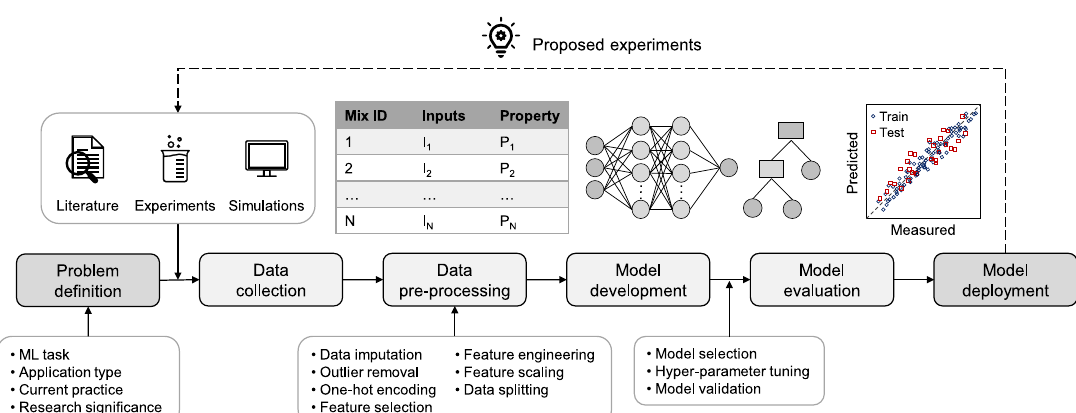
Fig. 4 General work fl ow of machine learning (ML) in concrete science. Six steps are typically involved in ML work fl ows, from (1) problem de fi nition, (2) data collection, and (3) data pre-processing to (4) model development, (5) model evaluation, and (6) model deployment. Developed ML models can be deployed to identify new concrete mixtures with desired properties, which are then validated through empirical or computational experiments, with the outcome appended to the collected datasets and iteratively calibrating the models. Relevant terminology and reporting guidelines can be found in Supplementary Notes 2 and 3,